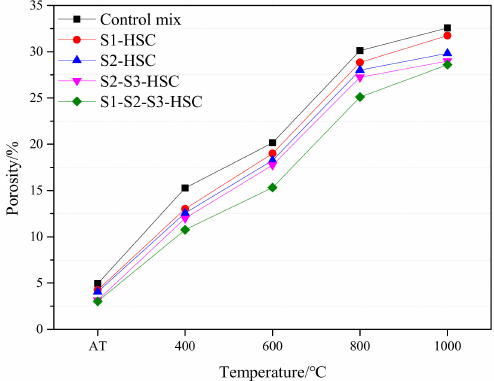
Figure 10. Porosity of the concrete subjected to elevated